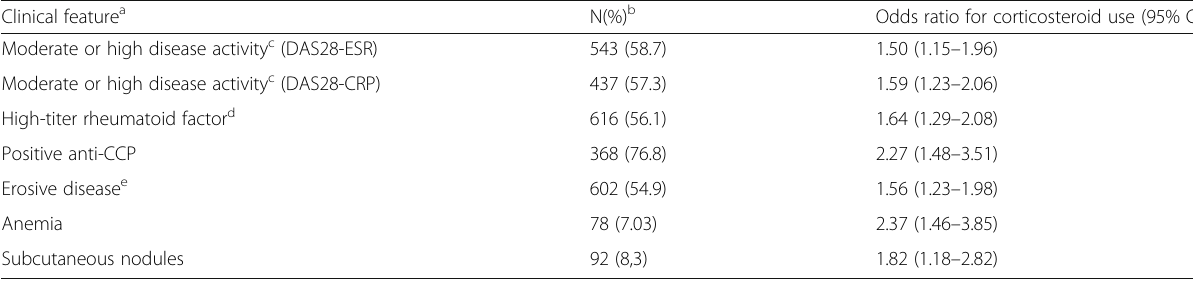
Table 3 Rheumatoid arthritis features associated with corticosteroid use Clinical feature